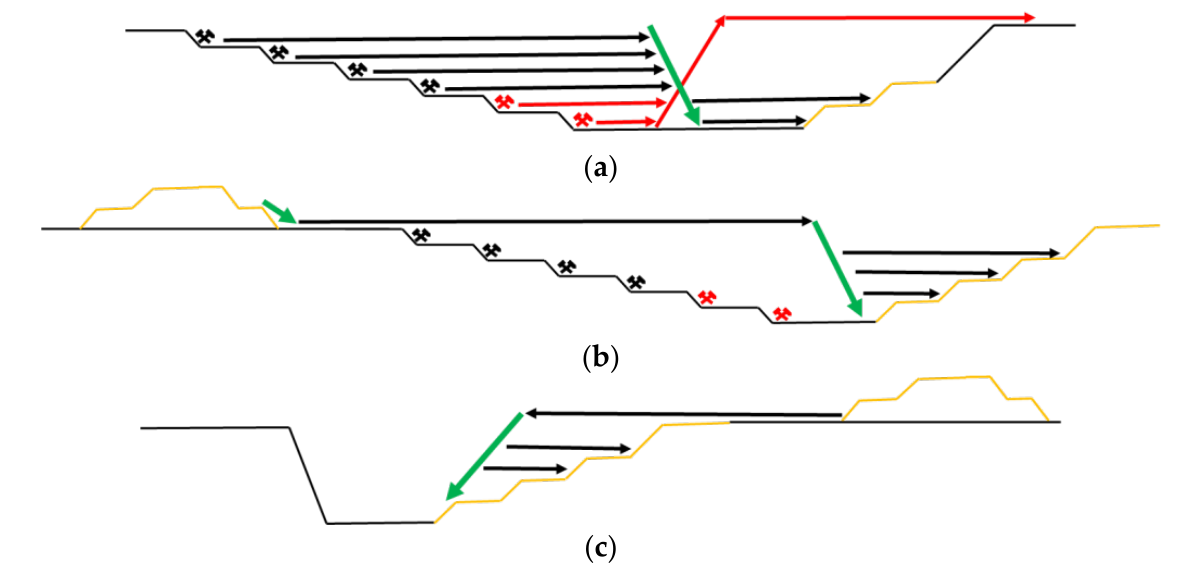
Figure 1. A schematic section through a continuous surface mine with various arrangements of overburden removal enabling the recovery of potential gravitational energy (red, black, green arrows–coal, overburden horizontal, overburden declined conveyors, respectively; yellow profile lines–dump sites, crossed hammers–exploitation levels); ( a ) Removing overburden volumes from mining levels to an in-pit dumping levels, ( b ) Translocation of overburden volumes previously temporarily dumped on a foreground to the final in-pit dumping levels, ( c ) partially liquidation of an external dump for the needs of reclamation earthworks of a post-mining void (shallowing and slopes